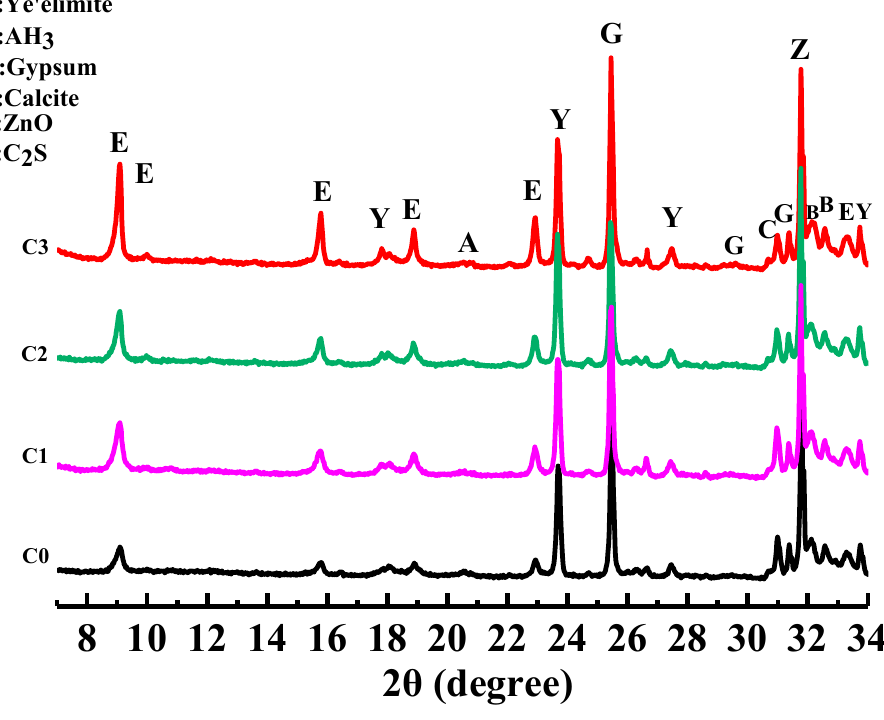
Figure 6. XRD patterns of SAC paste.